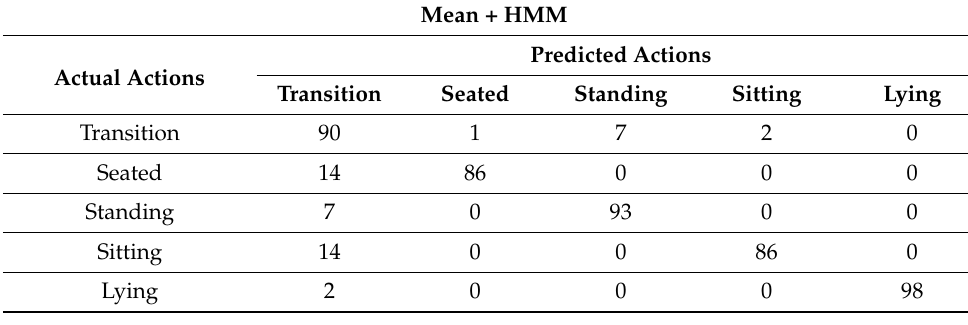
Figure 11. HMM, prediction on testing image sequences. Table 3. Confusion matrix of HMM prediction results tested on the training dataset.